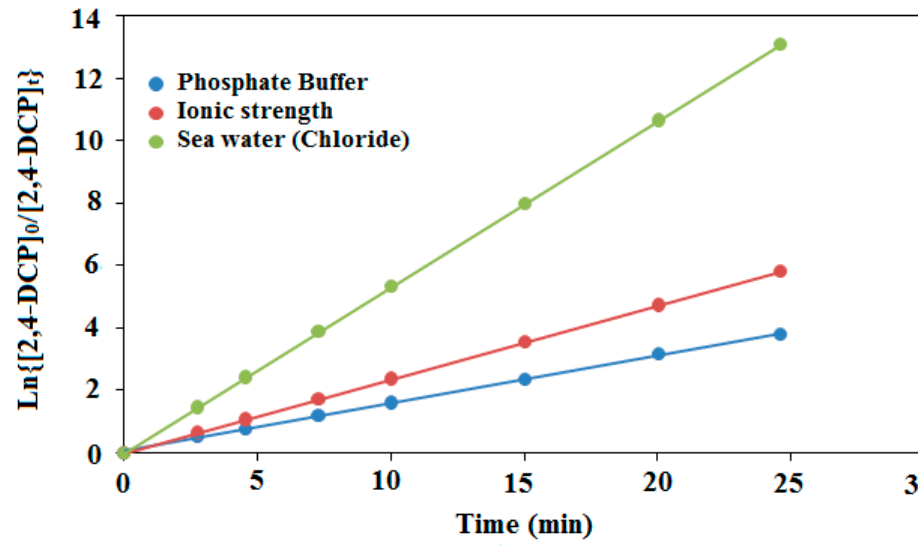
Figure 12. Photodegradation of 2,4-DCP target compound ([2,4-DCP] 0 = 5 mg / L) in synthetic sea water matrices containing 20 mM phosphate buffer alone at pH = 8, with 683 mM seawater (chloride), or with 683 mM NaClO 4 (ionic strength) after 30 min illumination time.